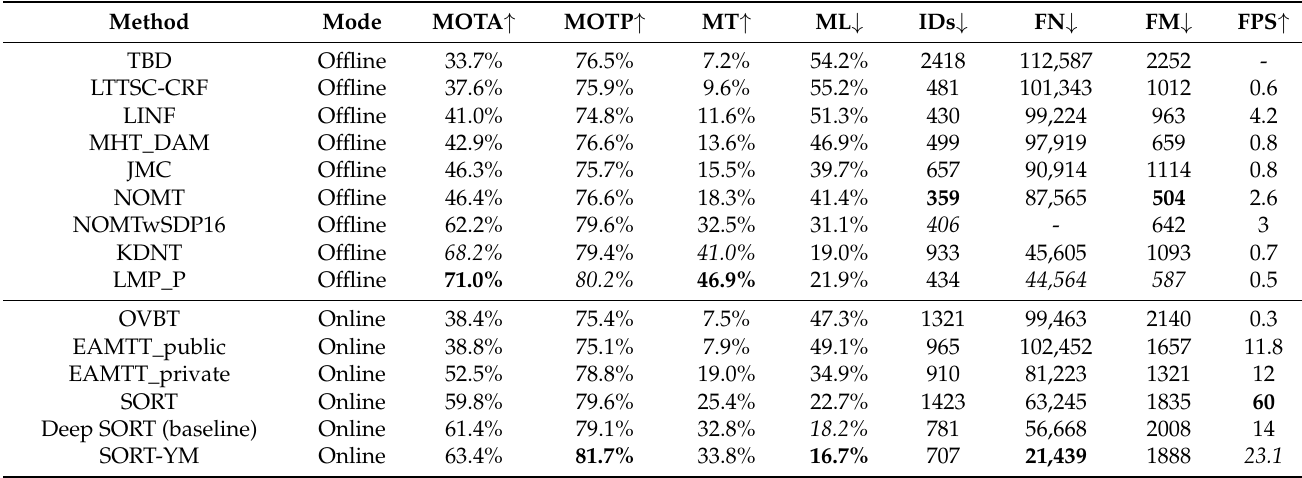
Table 4. The quantitative results by our proposed method and state-of-the-arts on MOT-16 dataset. ↑ Denotes that higher is better and ↓ represents the opposite. The best and sub-optimal results are highlighted in bold and